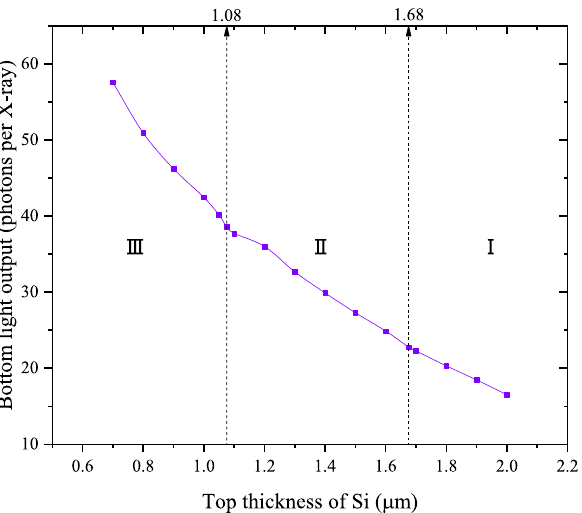
Figure 3. Bottom Light output of the structured CsI(Tl) screen varies with the top thickness of Si